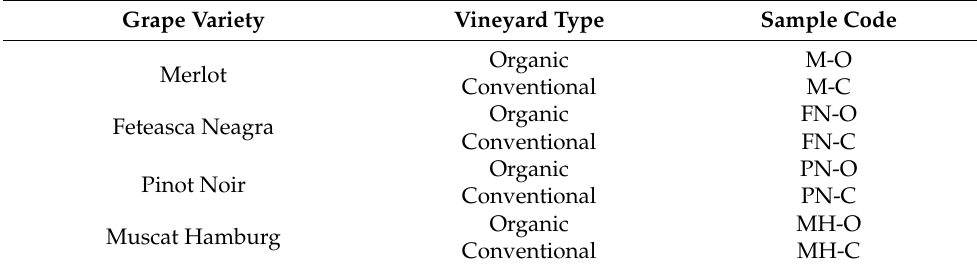
Table 1. The red grapes ( Vitis vinifera L.) investigated